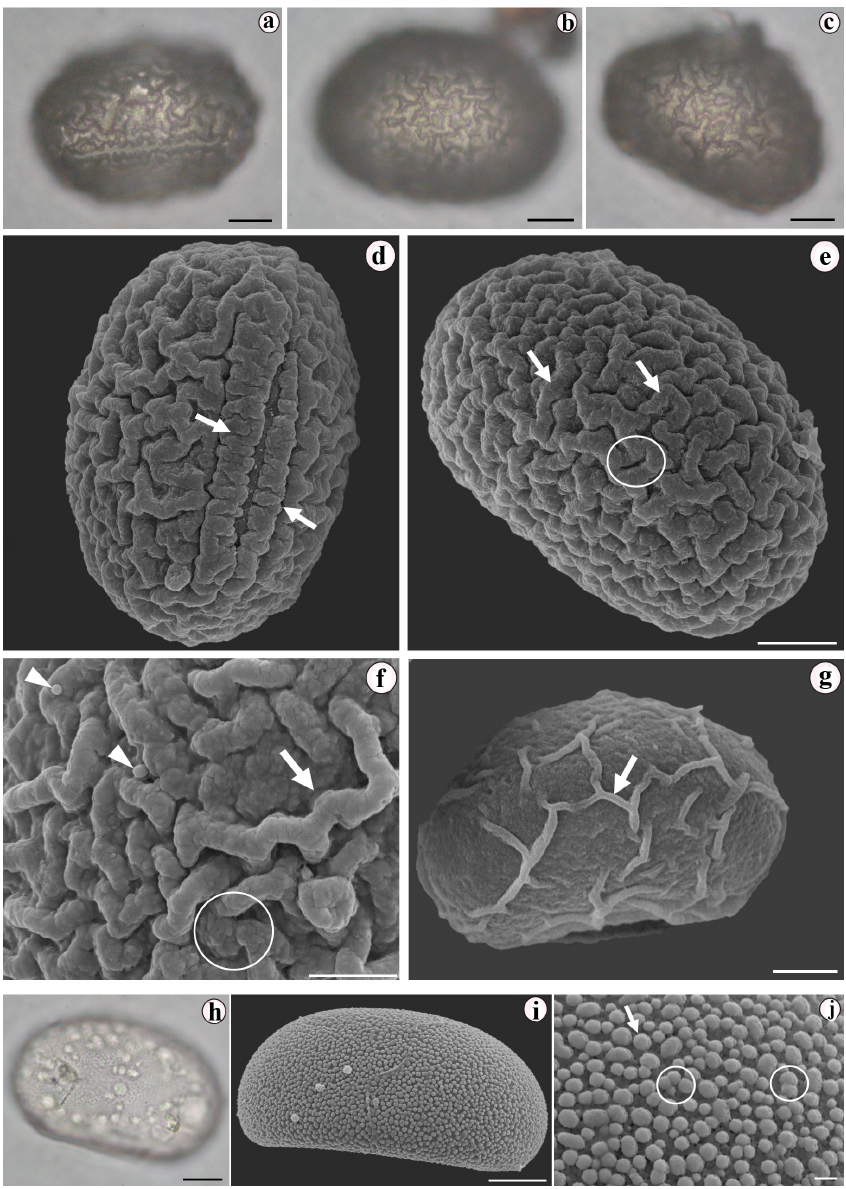
Figure 2 - Spores of Paesia glandulosa with LM and SEM. Rugulate sculpture. Figs. a-c. Mature spores with LM. a. Proximal view. b. Distal view. c. Equatorial view. Figs. d-g. Spores with MEB. d. Spore in proximal view, with short ridges adjacent and perpendicular at the laesurae (arrows). e. Spore in distal view. Sinuous ridges that conform an laberhintic arrangement (arrows) cover the surface. Ridges are fused and form open and isolated luminae (circle). f. Detail of distal view. Ridges (arrow) are separated by narrow spaces. The surface of ridges is granulose (circle) and spheroid bodies can be seen (arrowheads). g. Spore in equatorial view. In few spores analyzed, isolated ridges like crest were observed (arrow). Figs. h-j. Spores without perispore. h. Spore in distal view with LM. i . Detail of distal view with SEM. j . Spore in equatorial view with SEM. The exospore is covered with tubercles distributed at random. Tubercles with psilate or granulate surface are distributed at random (arrow) and can be fused in groups (circle). Specimen MP 4226. Scale bars = a-e , g-i = 10 µm; f = 5 µm; j = 1